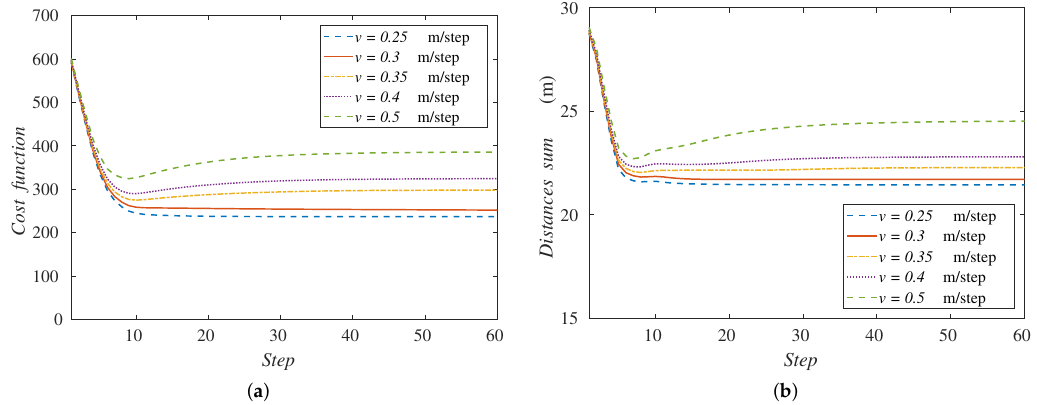
Figure 7. Performance metrics: ( a ) cost function and ( b ) sum of agents’ distances to the formation center, along the simulation depending on the formation velocity.